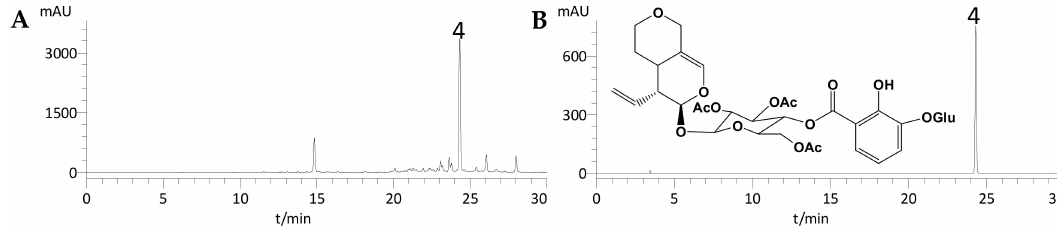
Figure 3. HPLC chromatograms of ( A ) sample 2 and ( B ) compound 4 separated by